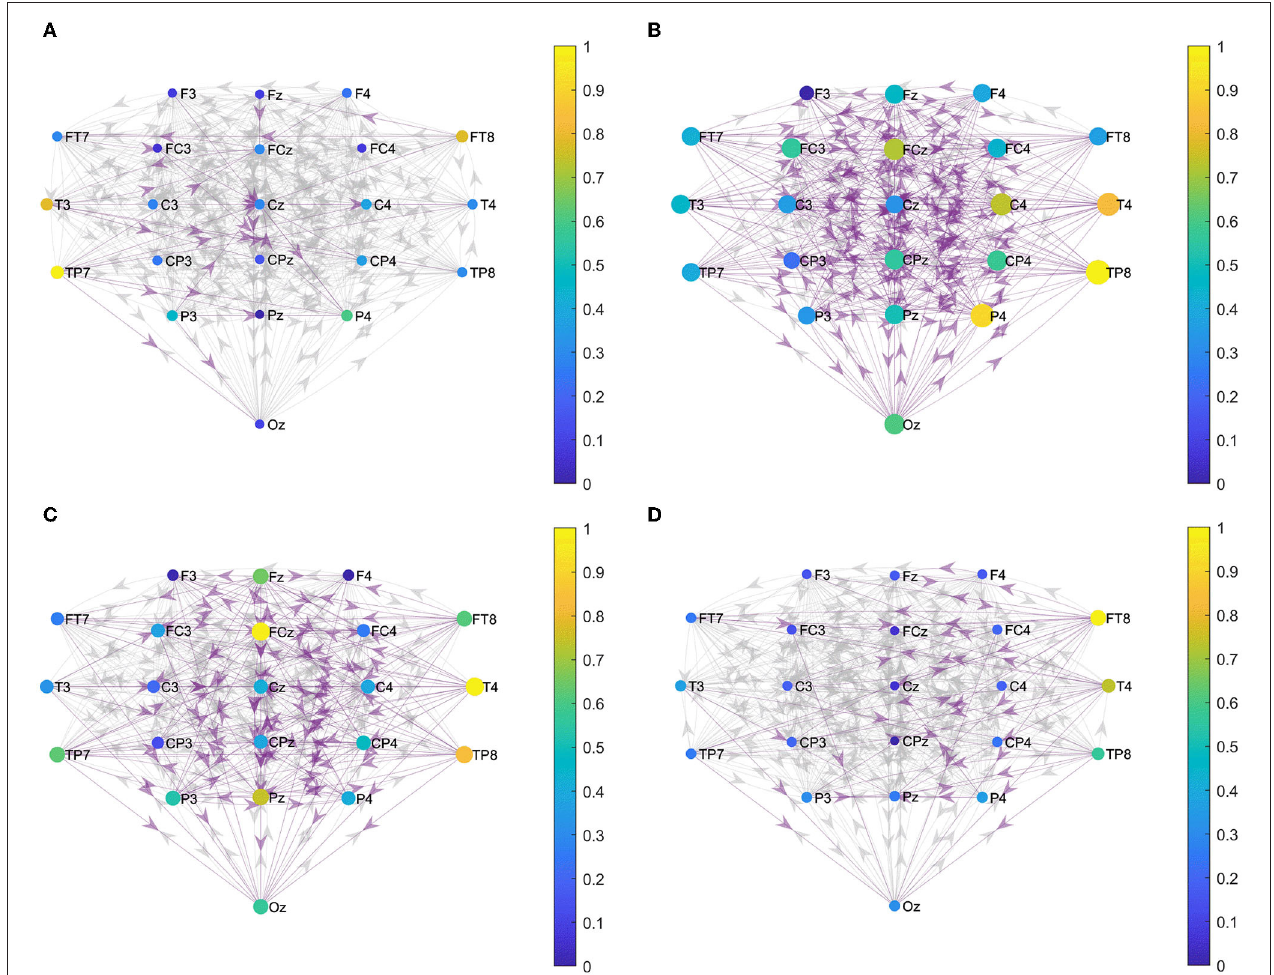
FIGURE 6 | Effective connections between hemispheres. (A) BCI–FES group before intervention; (B) BCI–FES group after intervention; (C) FES group before intervention; and (D) FES group after intervention. Gray edges indicate connections below the threshold, red edges represent effective connections within the ipsilesional hemisphere, blue edges indicate effective connections within the contralesional hemisphere, node size represents node strength, and node color indicates normalized node strength. The direction of the arrow indicates the direction of information